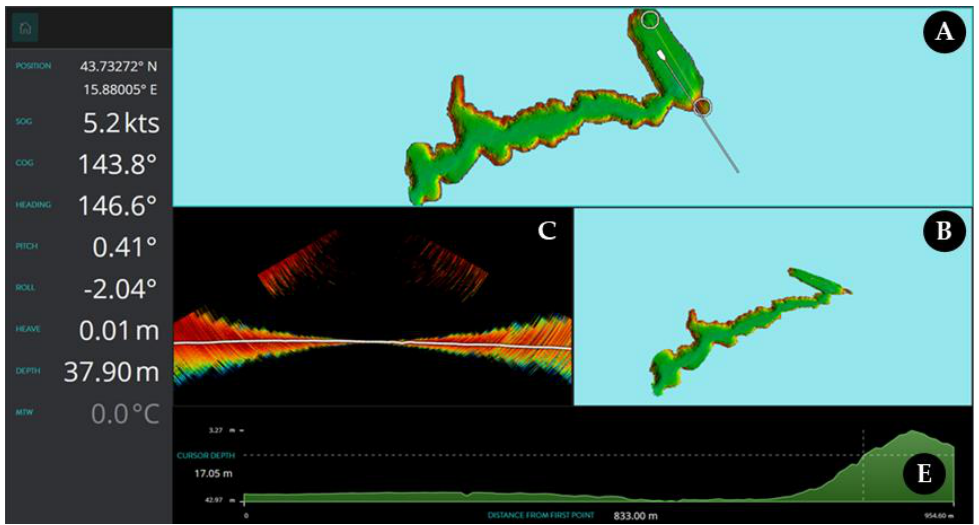
Figure 5. The views of the recorded area: ( A ) two-dimensional; ( B ) perspective (3D); ( C ) sonar field; ( E ) profile.